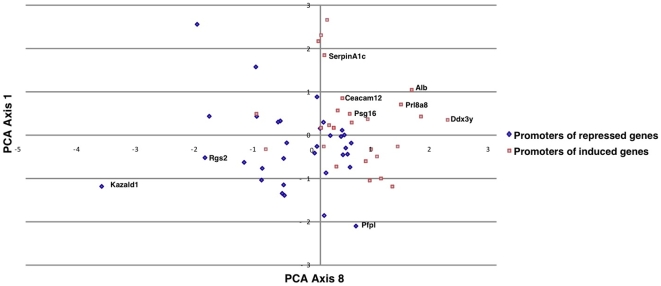
Projections of promoters of induced and repressed genes on axes 1 and 8 after PCPCA (Promoter Content Principal Component Analysis).The axes were defined by PCA from a cross table representing the number of putative transcription factor binding sites in each promoter (60 promoters analyzed corresponding to the 17 most induced and 17 most repressed genes). Among the variable was also added the induction ratio, which permitted to identify the axes that were the most strongly correlated with these ratios (axes 1 and 8). These were chosen for the graphical representation. As clearly shown, there is a very clear dichotomy between induced and repressed promoters when the coordinates calculated for the two axes are used. For clarity, examples of promoters were annotated on the graph.